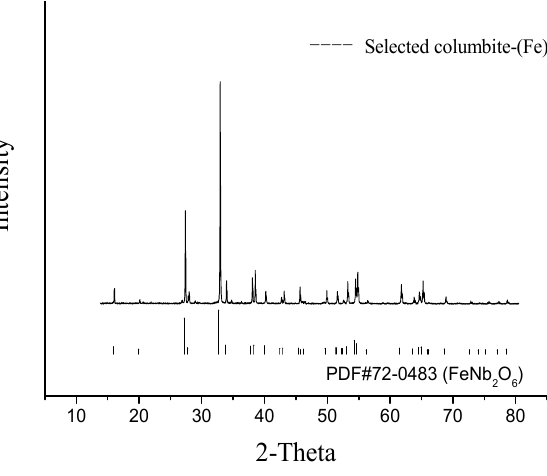
Figure 4. XRD pattern of selected columbite–(Fe).